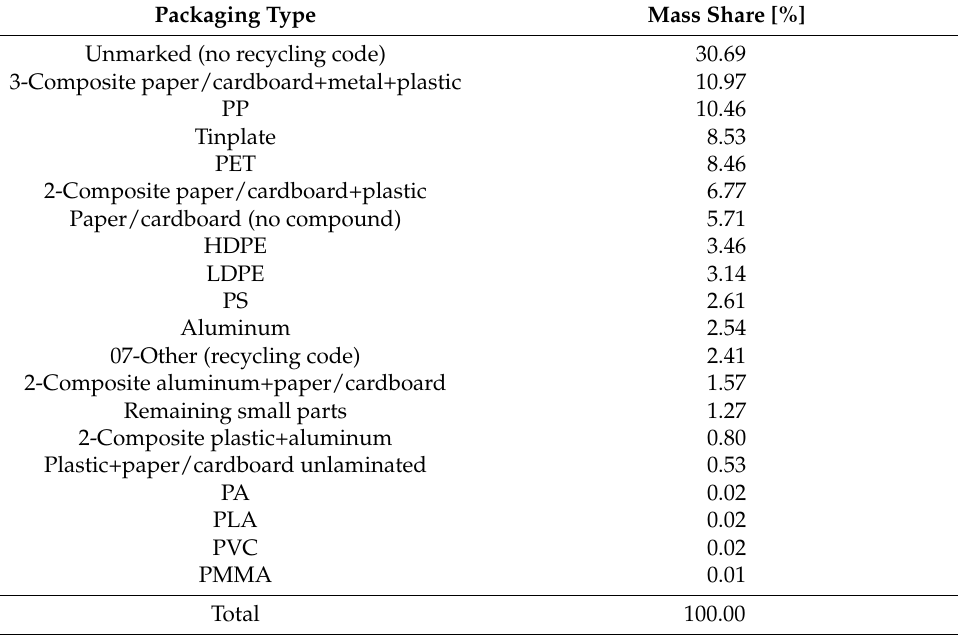
Table 4. Packing material distribution of the original sample, based on a total of 188,869 g, based on [46]. Packaging